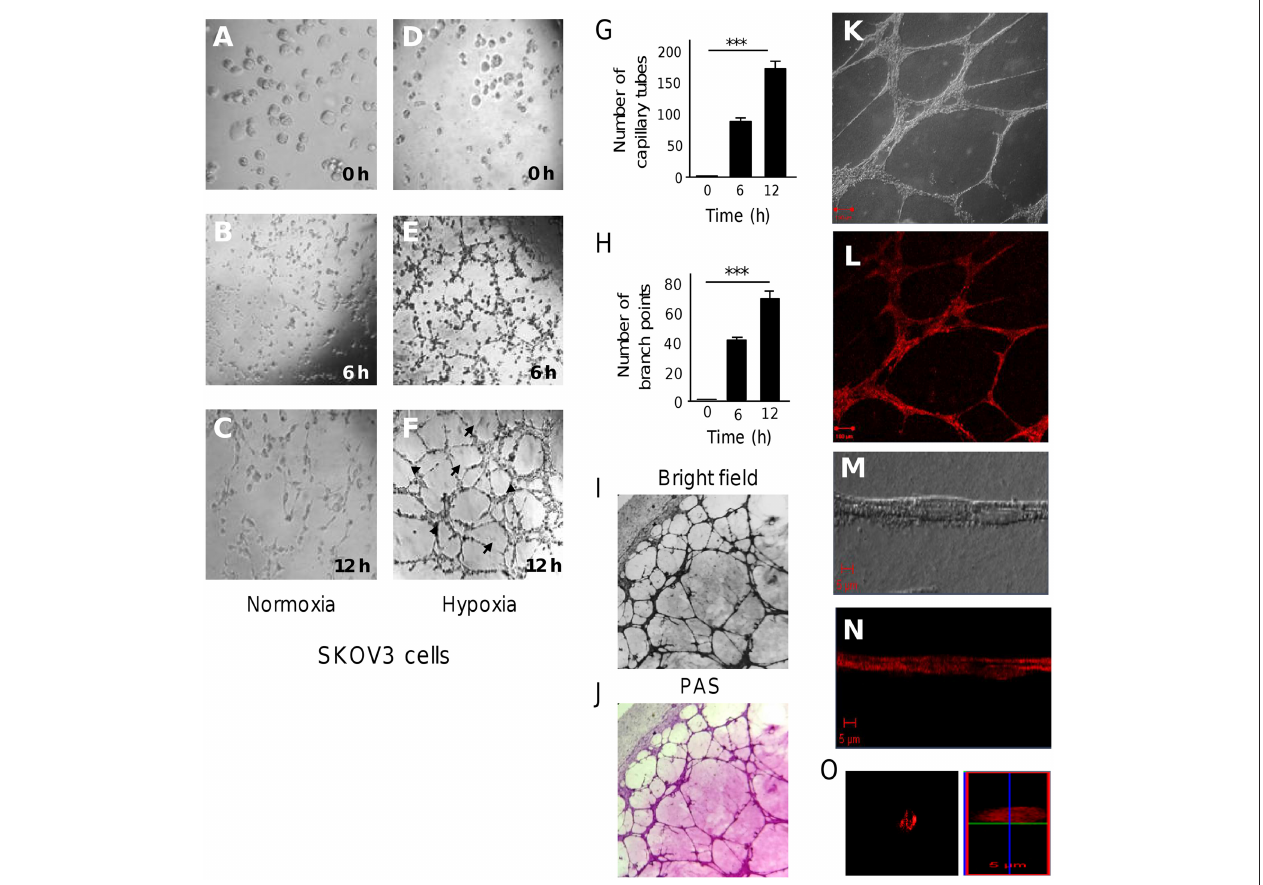
FIGURE 1 | 3D channels-like formation in SKOV3 ovarian cancer cells. (A-F) SKOV3 cells were previously incubated onto matrigel with serum free medium for 12h (time 0), and then imaged during course of time (0–12h) as showed in (A-C) normoxia and (D-F) hypoxia conditions. Arrows denote the capillary-like tubes. Arrowheads denote the branch points. (G) Graphical representation of quantification of cellular networks and (H) branch points number after 0, 6, and 12h. Experiments were performed three times by triplicate and data were expressed as mean ± S.D. *** p < 0.001. (I) Bright field images (10 × ) and (J) Periodic acid-Schiff (PAS) stained images (10 × ) of cultures on matrigel. (K-O) Images of 3D-culture observed under confocal laser-scanning microscopy. Cells in (K,M) clear field and stained with (L,N,O) rhodamine-phalloidin. (O) Confocal microscopy Z-stack reconstruction of cellular networks.